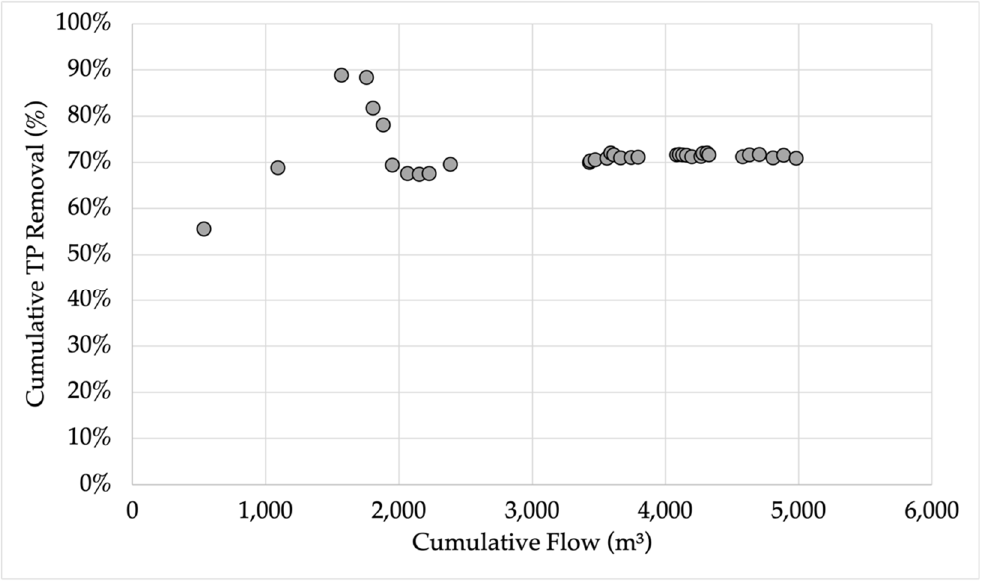
Figure 5. Flow-weighted TP removal calculated cumulatively for each storm event as a function of the cumulative flow that passed through the spent lime DWTR.